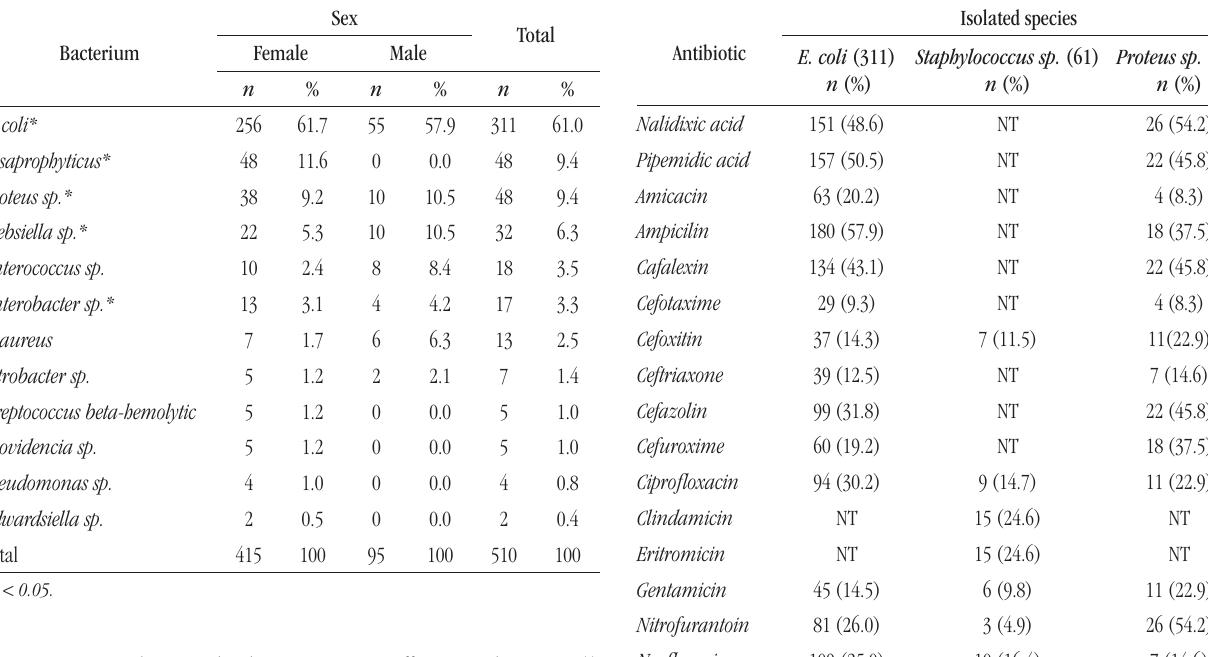
tABLE 2 – Frequency of microorganisms isolated at clinical analysis laboratories in Jataí, from March 2010 to June 2012